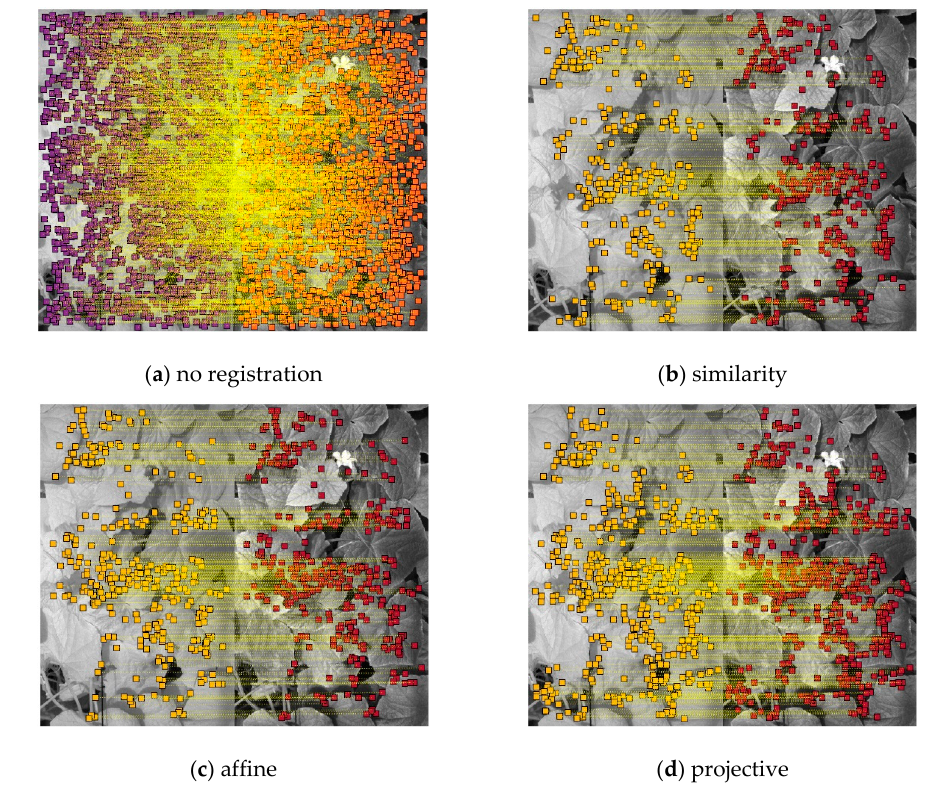
near to the left and right edges of the images (Figure 10). However, the projective trans- formation missed points in the top right corner of the image (Figure 10). The resulting RGB composite images after applying the imwarp function are presented in Figure 11. All three transformation types produce good alignment, but some blurry regions can be ob- lower corner of each image (Figure 11). served in the left lower corner of each image (Figure 11).